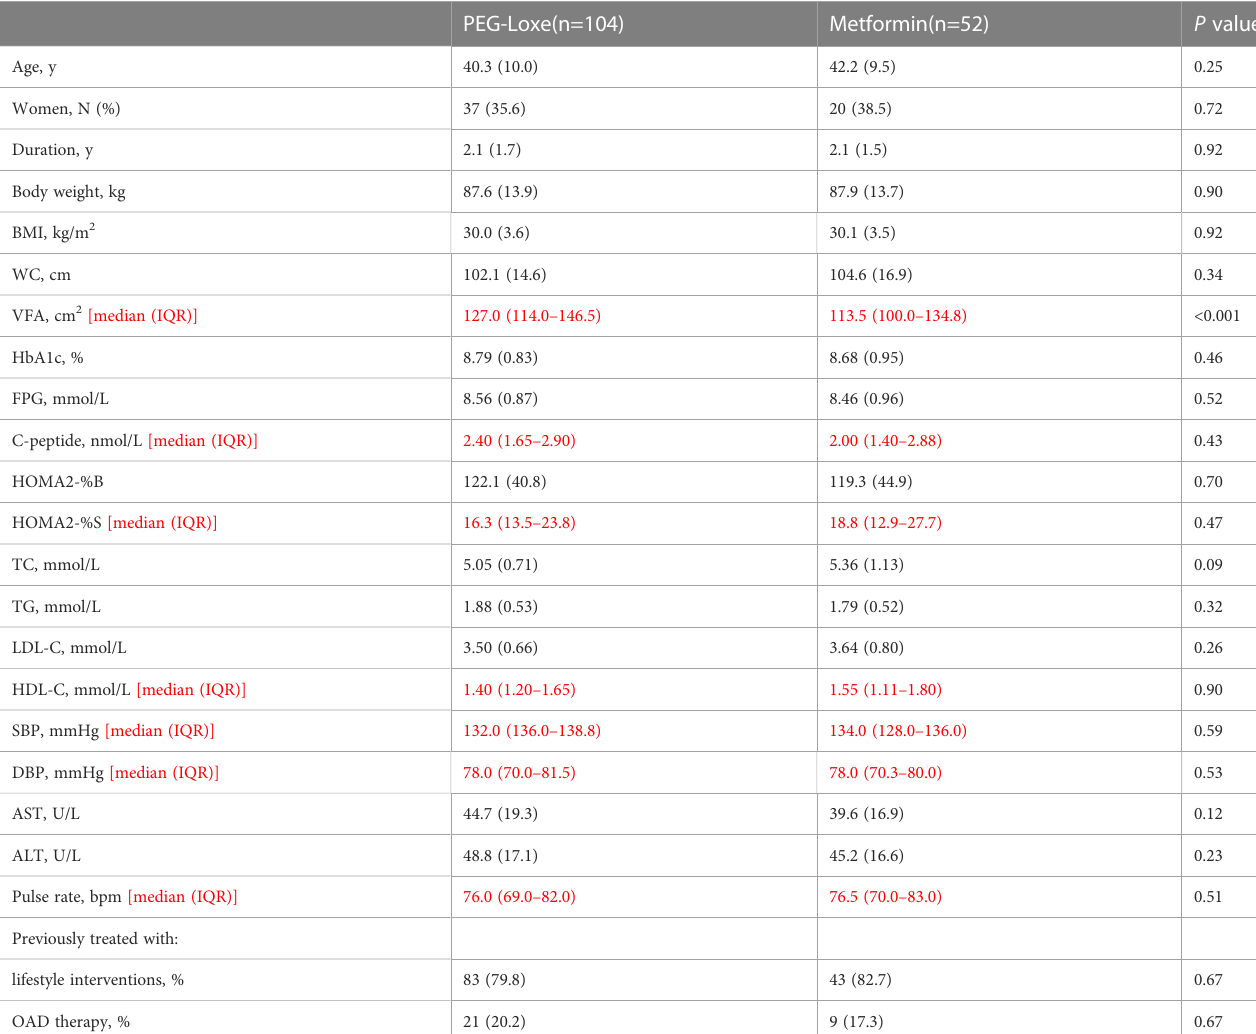
TABLE 1 Baseline characteristics of